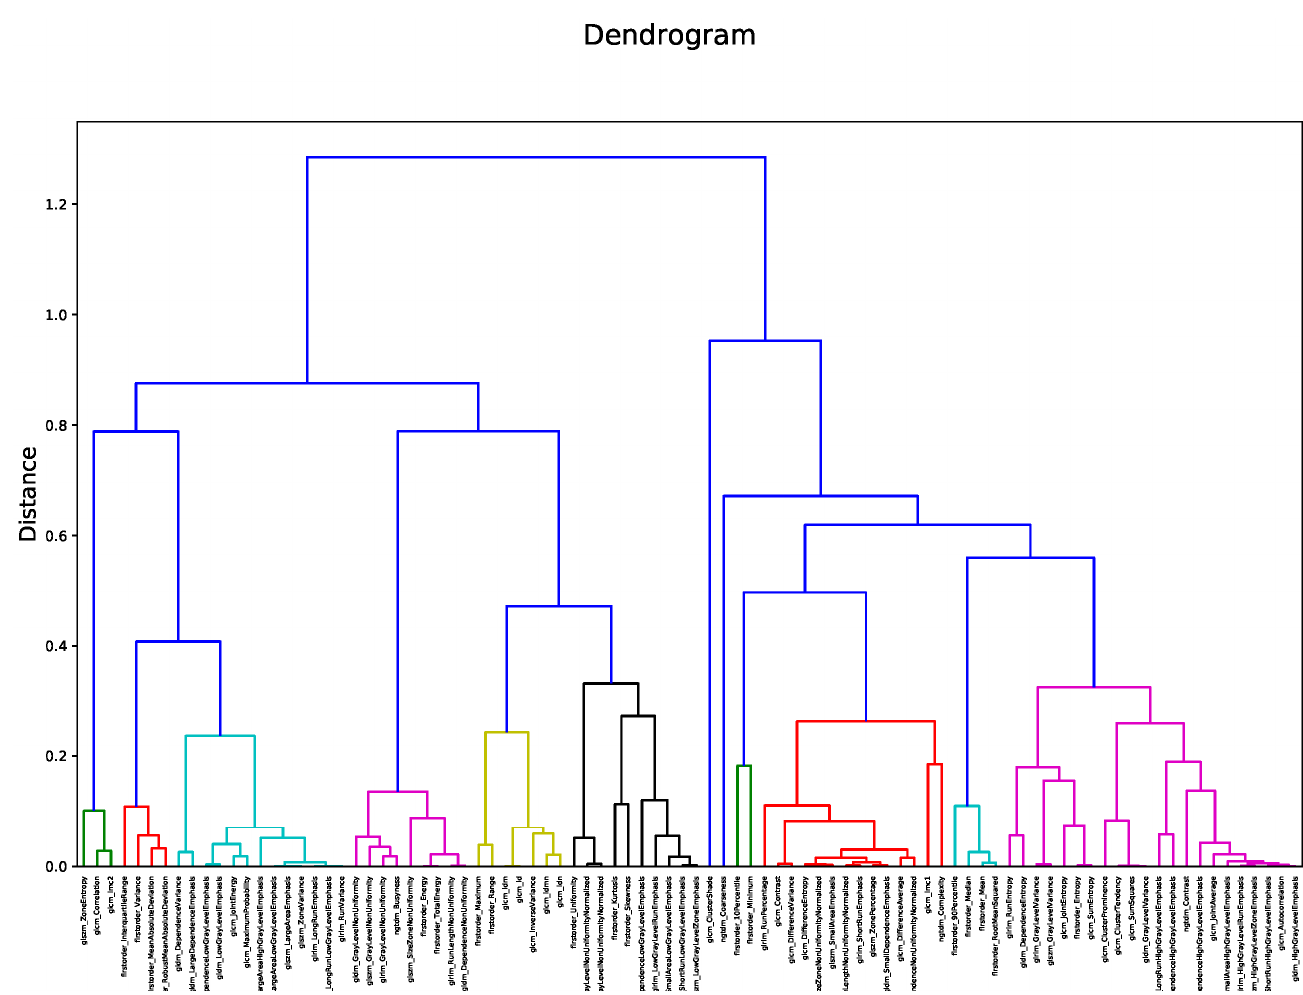
Figure 3. Dendrogram output for hierarchical clustering. The 12 identified clusters are highlighted in different colors.